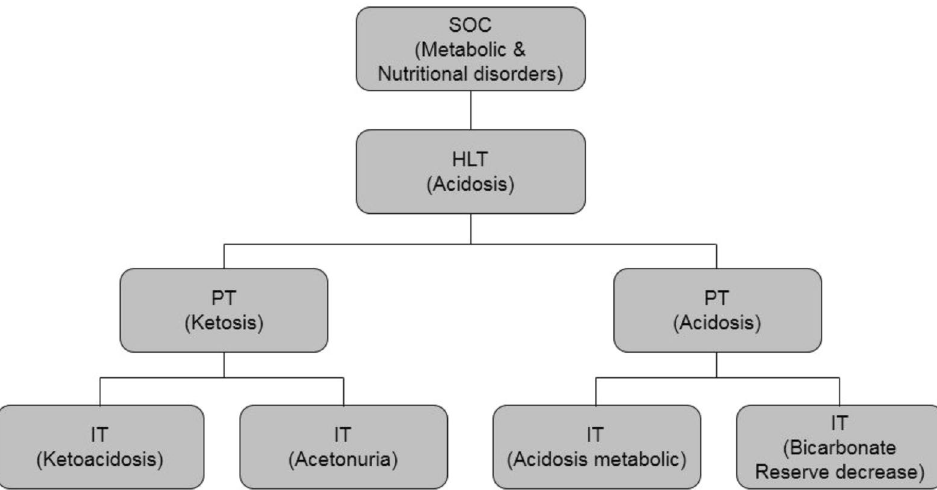
Figure 1. WHO-ART